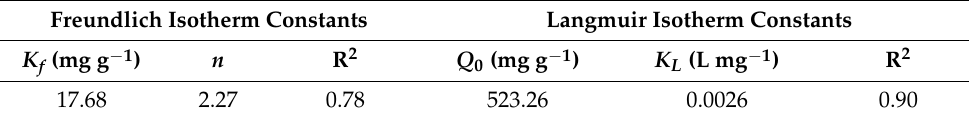
Table 5. Freundlich and Langmuir isotherm constants for the adsorption of COD in GAC. Freundlich Isotherm